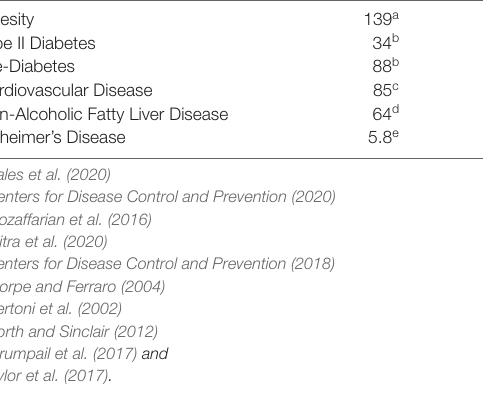
TABLE 1 | Alzheimer’s and cardiometabolic disease prevalence in the US, 1998 to 2020.